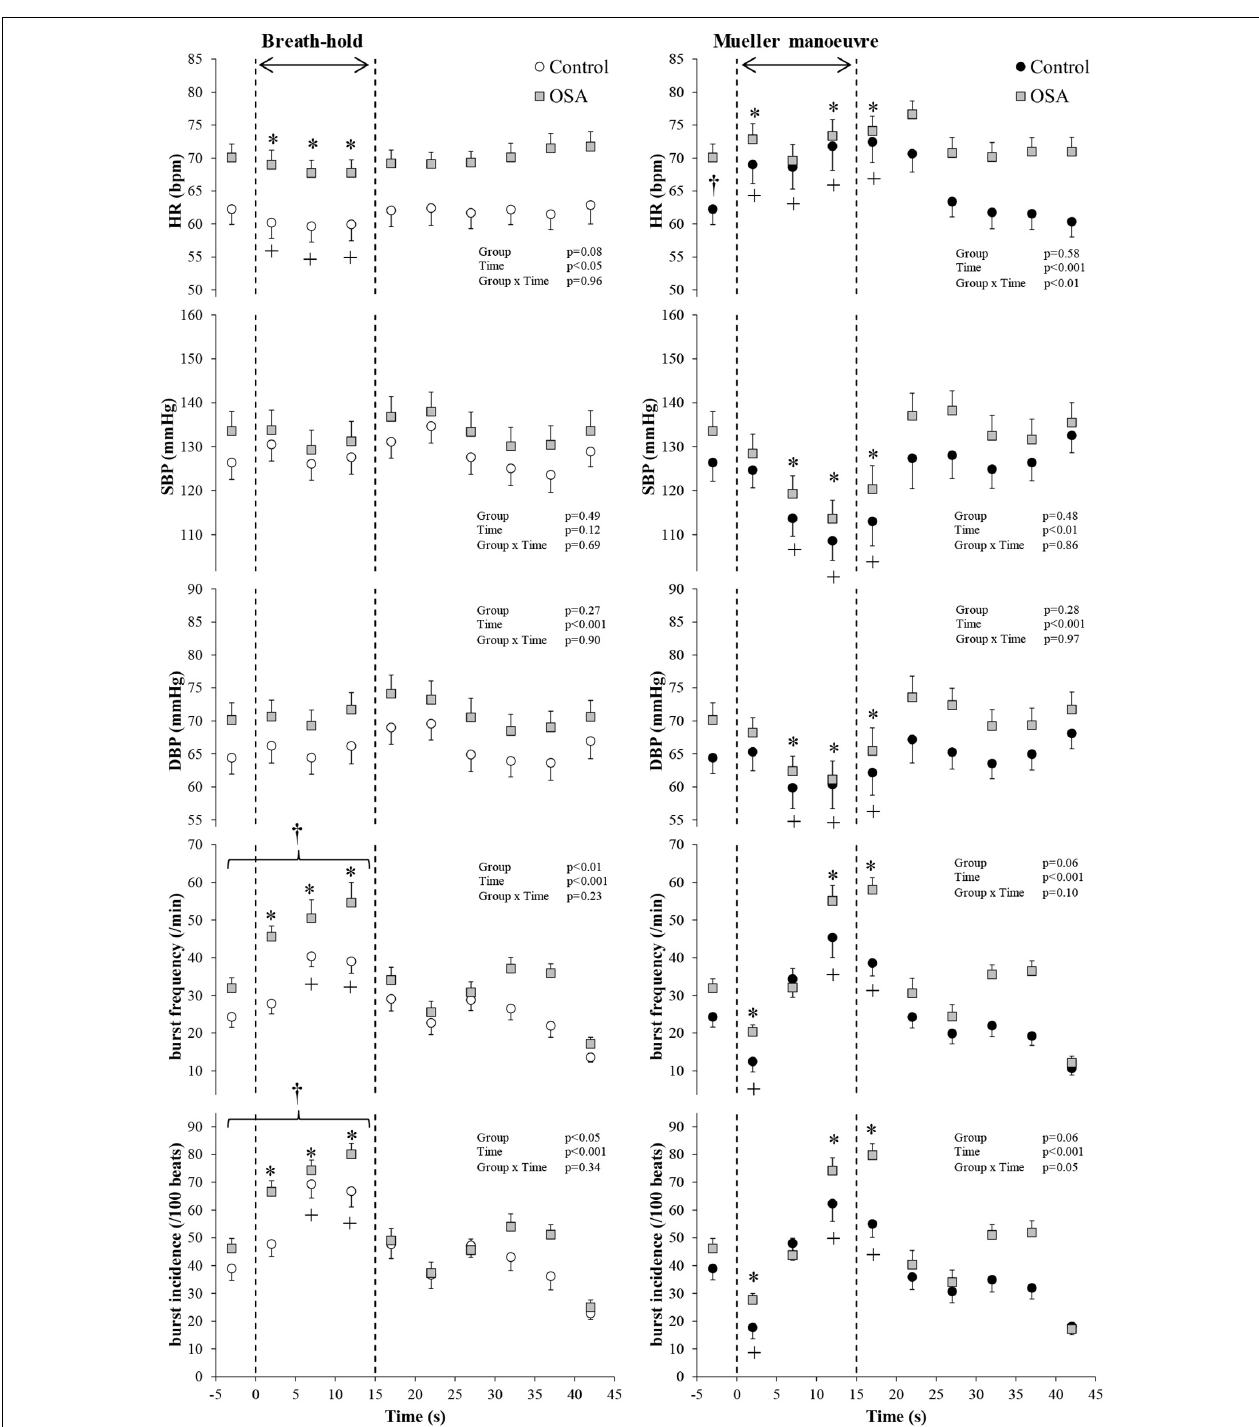
FIGURE 4 | Participants with both blood oxygen level-dependent (BOLD) functional magnetic resonance signals meeting inclusion thresholds (see text) and high-quality mean voltage neurograms. Mean ( ± 95% confidence limits) HR, SBP, DBP, and MSNA responses before, during, and after the series of 15 s of end-expiratory breath-holds ( left ) and 15 s of Mueller maneuvers ( right ) in 14 individuals with obstructive sleep apnea (OSA, gray squares) and 10 healthy controls ( white and black circles) are displayed. The dashed vertical lines indicate the beginning (time = zero) and end (time = 15 s) of both maneuvers. Continuous responses were bin-averaged at 5-s intervals. For breath-holds, data during the 15 s of the task were compared with baseline values. For Mueller maneuvers, due to the time delay preceding sympathetic excitation, data during the 15 s of the task plus the first 5-s interval following the task were compared with baseline values. † p < 0.05 compared to the control group; ∗ p < 0.05 compared to pre-maneuver (i.e., − 2 s) in healthy controls; + p < 0.05 compared to pre-maneuver (i.e., − 2 s) in OSA.